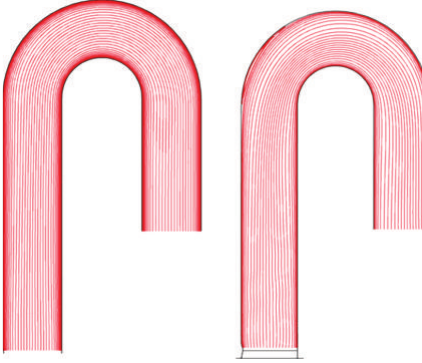
Figure 9: Flows paths at mass flow 0.4 kg/s, first-order upwind and second-order central discretization.